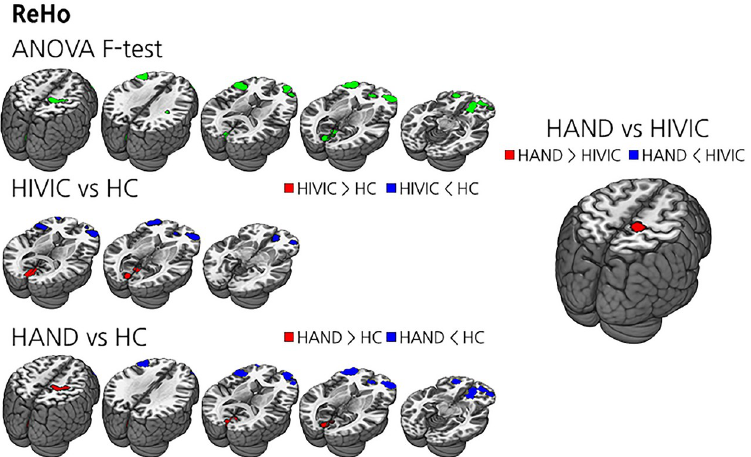
Fig 1. The results of ReHo analysis. (Top left) ANOVA results between HAND, HIV-IC and HC. Green clusters are voxels with significant ANOVA results. (Middle left) t -test results between HIV-IC and HC. Blue clusters represent lower ReHo regions of HIV-IC and red clusters represent the opposite. (Bottom left) t -test results between HAND and HC. Blue clusters represent lower ReHo regions of HAND and red clusters represent the opposite. (Right) t -test results between HAND and HIV-IC. Blue clusters represent lower ReHo regions of HAND and red clusters represent the opposite.